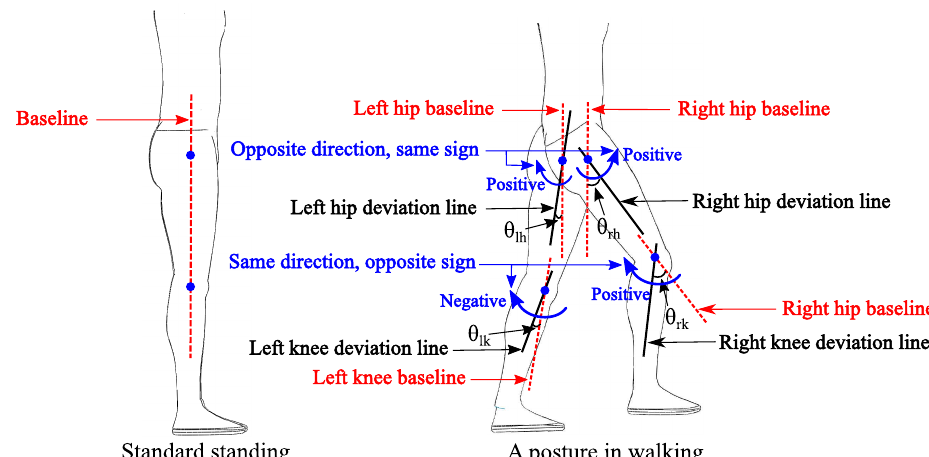
Figure 1. The definitions of the joint angle deviating from standard standing. The left is standard standing, and the right is a posture in walking. The red lines are the baselines, and the black lines are the deviation lines from the baselines. To distinguish the legs, the joint angles are defined as opposite signs, while they are in the same rotary